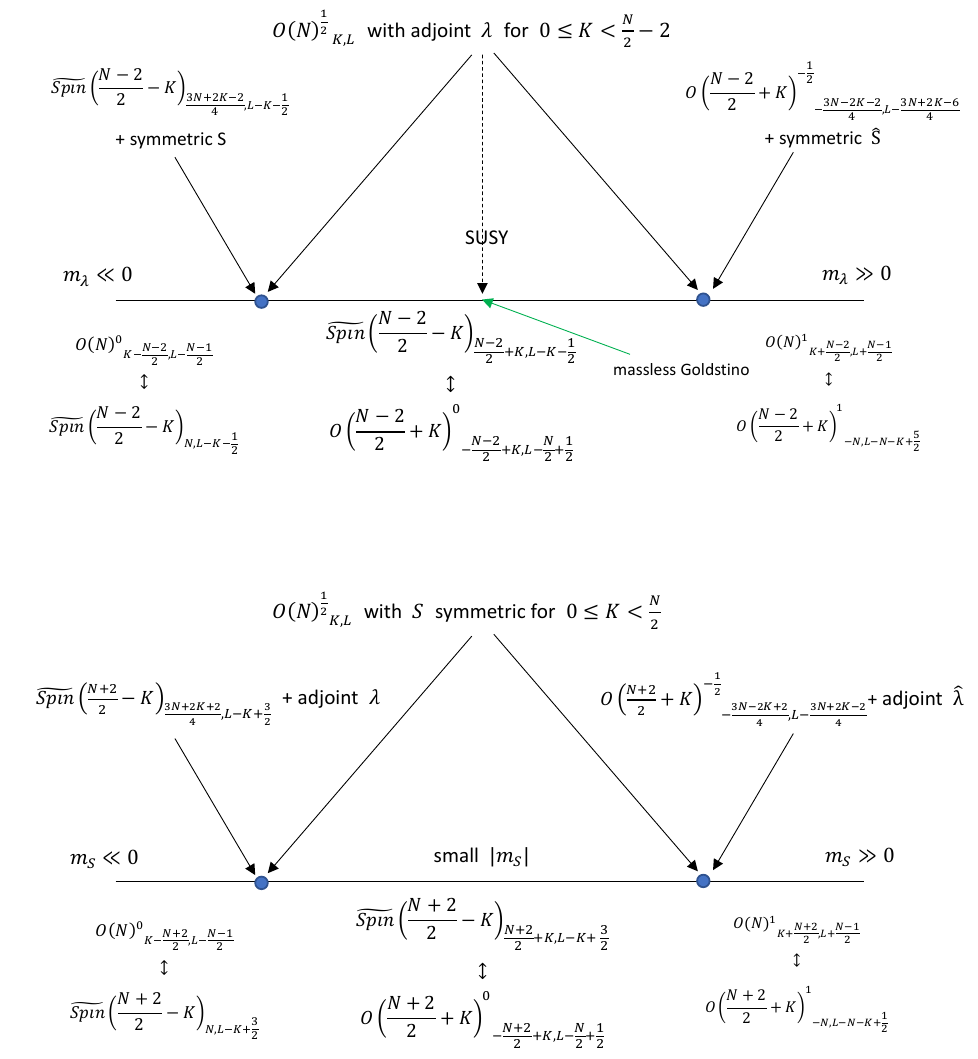
1 Figure 6: The phase diagrams of O ( N ) 2 gauge theory coupled tensor fermions. The infrared TQFTs, together with relevant level-rank duals are shown along the bottom. The blue dots indicate the transitions from the semiclassical phase to the quantum phase. This proceeds through a tensor transition described by a dual theory, which covers part of the phase diagram. Across these tensor transitions O ( L ) 0 and O ( L ) 1 are exchanged. At a special value of the mass in the quantum phase of the adjoint (cid:93) Spin ( N ) theory, a massless goldstino appears. The notation is explained around K , L